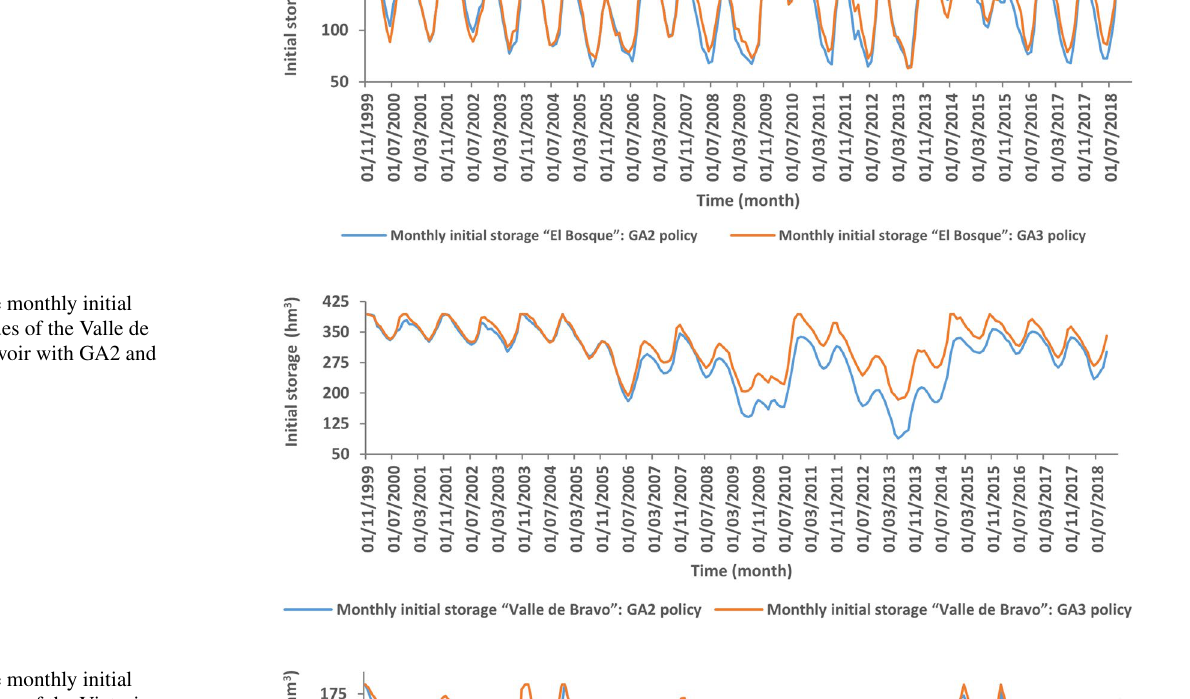
Fig. 17 The monthly initial storage values of the El Bosque reservoir with GA2 and GA3 policy